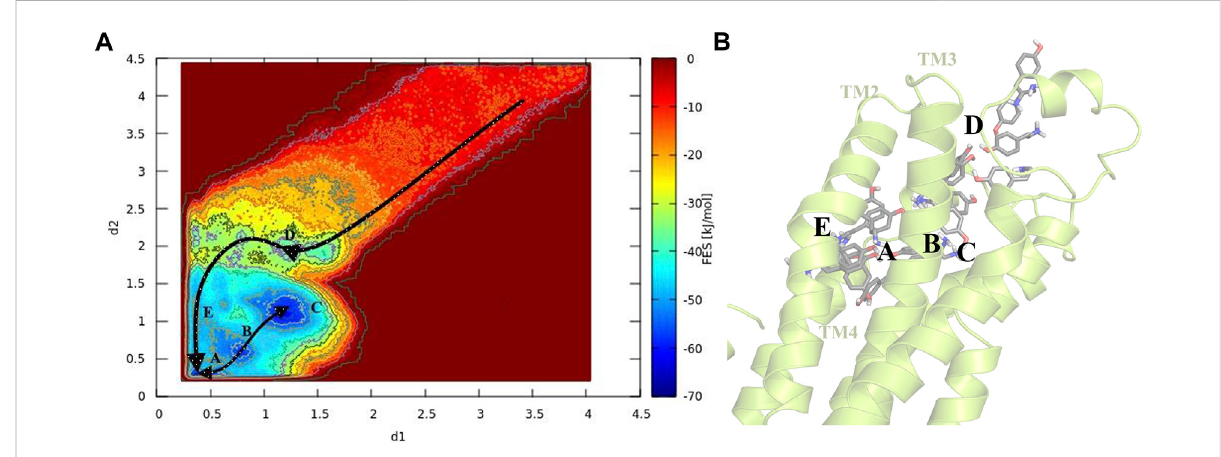
FIGURE 4 Schematic illustration of the binding pathway trajectory of TA against TyrR is depicted on (A) the FES and (B) the corresponding 3D structure of the protein. The trajectory showing the binding path is shown as arrows connecting each